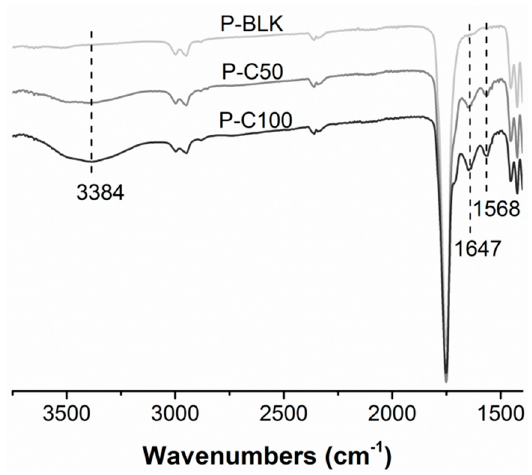
Figure 2. Attenuated total reflection Fourier transform infrared spectroscopy (ATR-FTIR) analysis of P-BLK (light gray), P-C50 (gray), and P-C100 (blank).